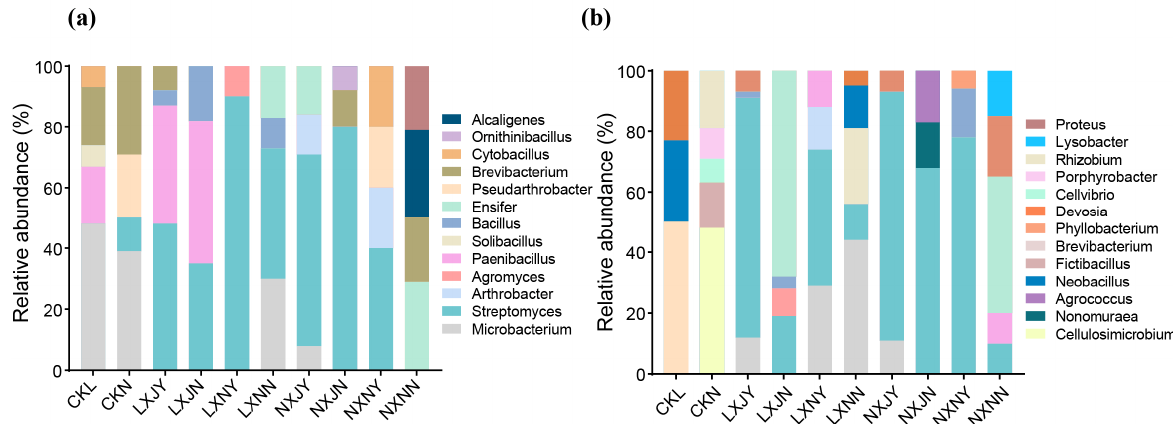
Figure 4. Relative abundance of bacterial genus levels in TSB ( a ) and R2A ( b ) media. CKL (blank control with O. cumana added), CKN (blank control without O. cumana added).